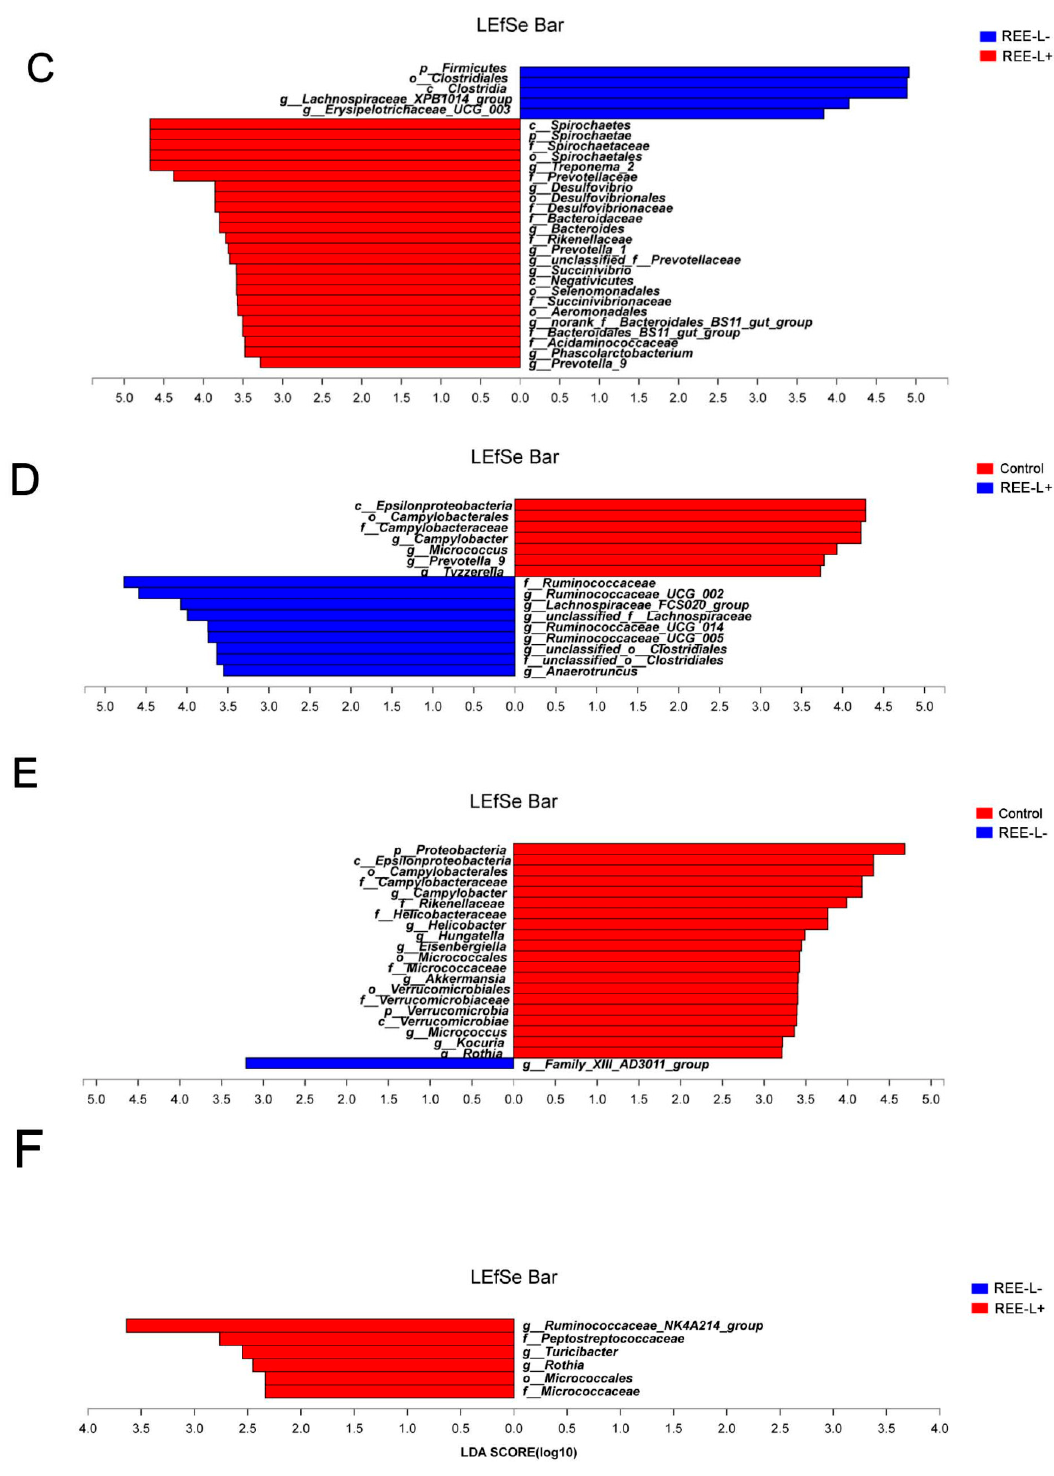
Figure 5. Linear discriminant analysis effect size (LEfSe) analysis of the different abundance of microbiota in fecal samples of ( A – C ) sows and ( D – F ) their piglets from phylum to genus levels. Histograms of a linear discriminant analysis (LDA) score (threshold > 2) are plotted. n = 8 per group. REE-L + , REE supplied during gestation and lactation. REE-L-, REE supplied in late gestation. (Please replace with a sharper image. (Minimum 1000 pixels width/height, or a resolution of 300 dpi or higher).